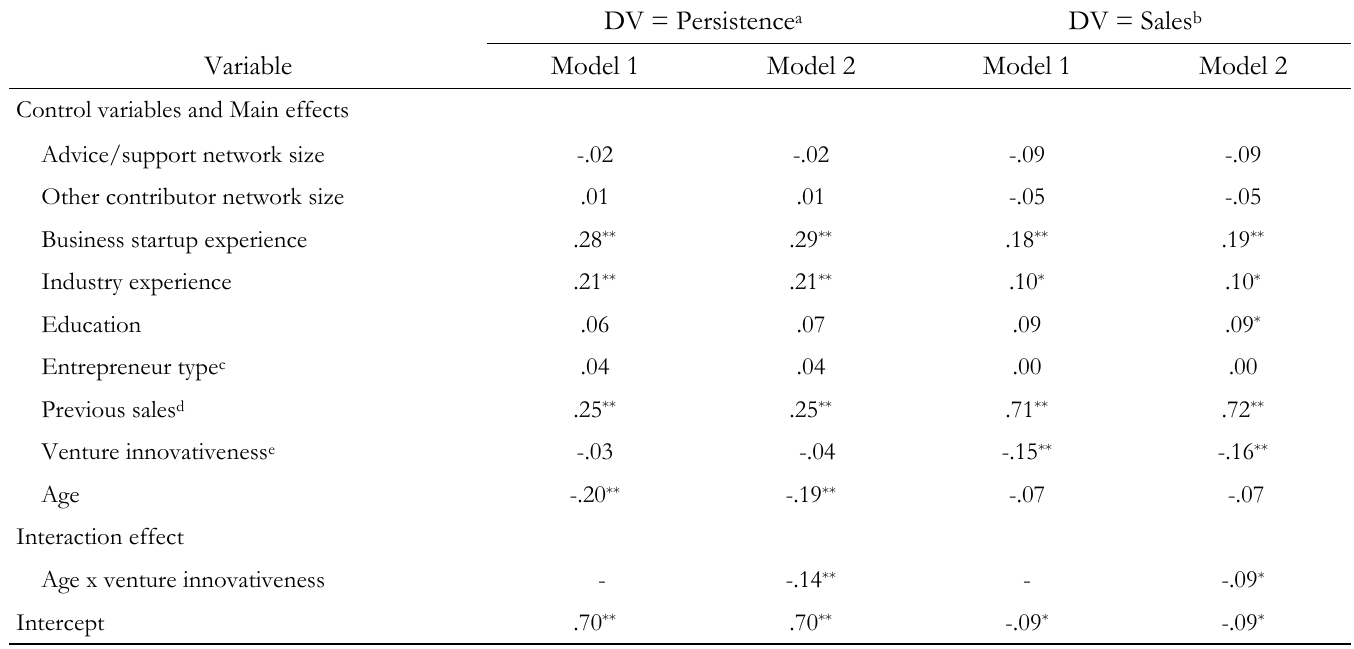
Table 2. GEE Results for the Moderating Effect of Venture Innovativeness on the Relationship between Entrepreneur Age and Venture Performance (Hypothesis 1 and Post-hoc Analysis